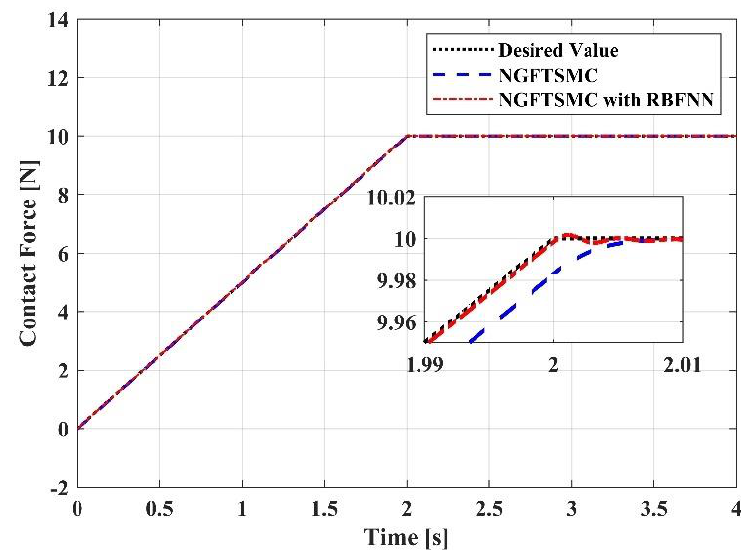
Figure 16. Contact force generated by the aerial manipulation.